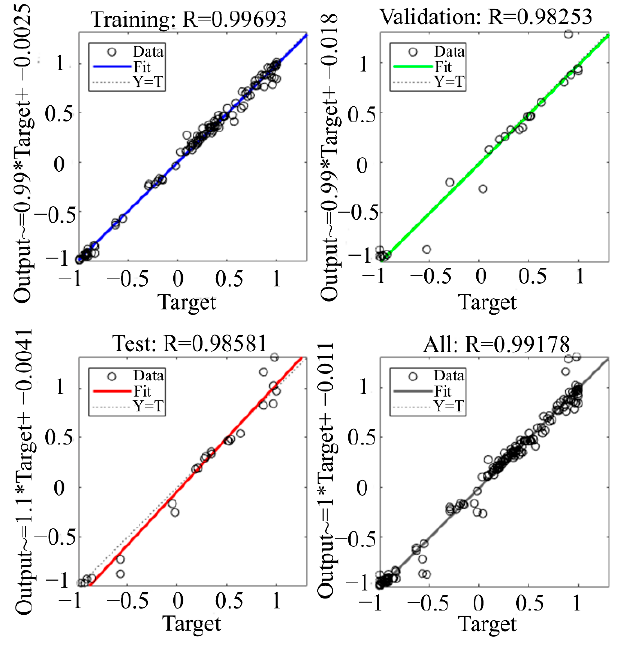
Figure 7. Fitting effect of network.